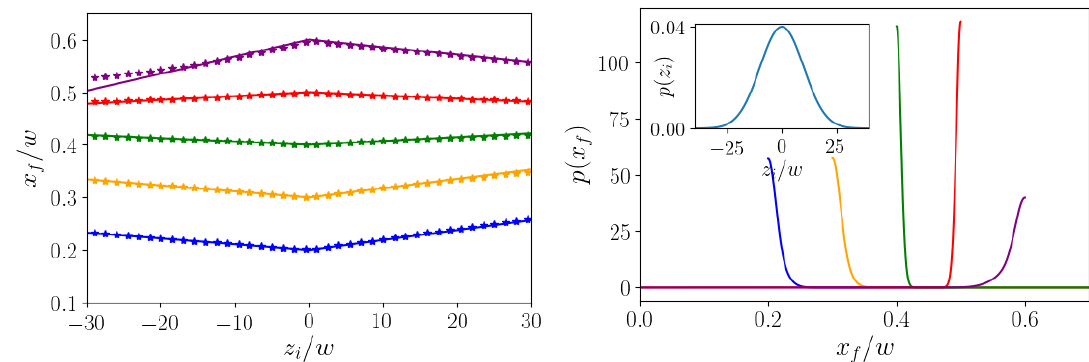
Figure 10. ( Left ): Final lateral position x f for particles with initial axial position z i when steered by the ( t ) , which is opimized for steering the central particle with z axial control force f ∗ ctl to different target positions x t / w = 0.2, 0.3, 0.4, 0.5, and 0.6 at the axial target position z t = 500 w . The linear fits by solid lines are hardly visible. ( Right ): Distributions of final lateral positions x f for the Gaussian distribution of initial axial positions z i shown in the inset. The colors indicate different target positions x t / w as in the plot on the